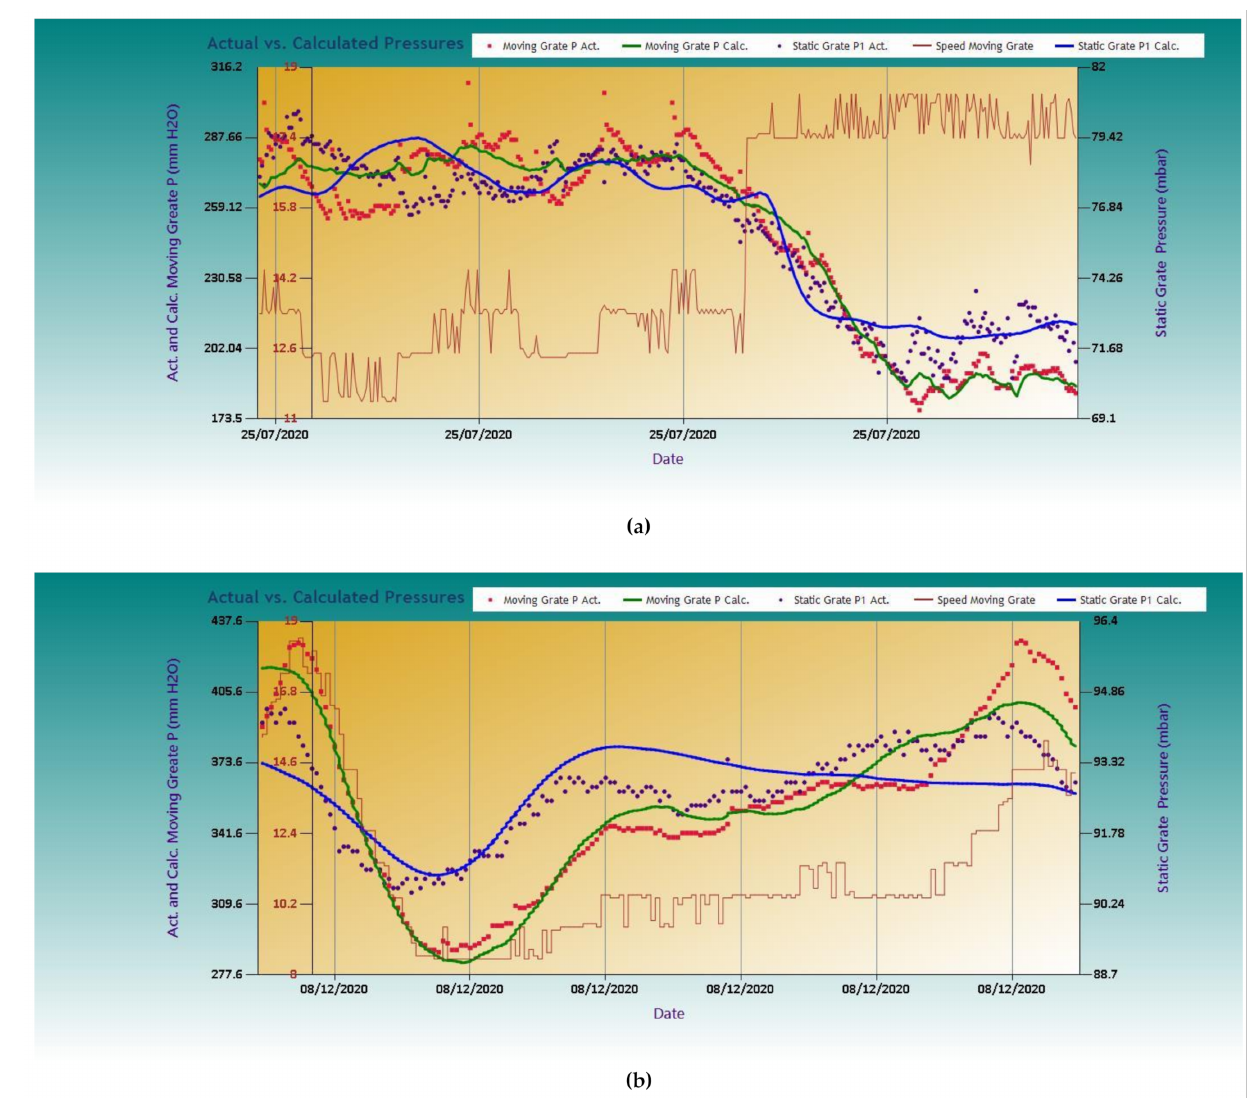
Figure 5. Calculated vs. actual values for the models: ( a ) N p = 6, N g = 6; ( b ) N p = 4, N g =